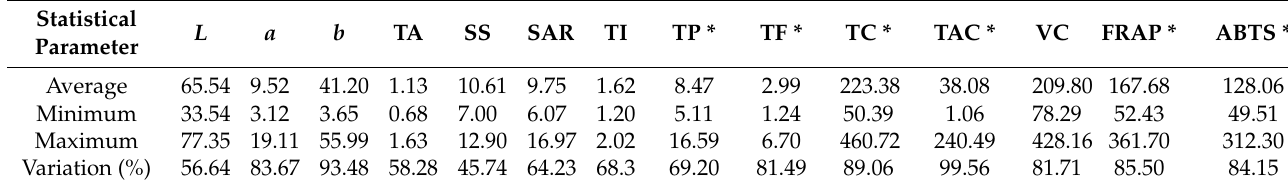
Table 1. Color and chemical parameters from the tree tomato breeding population.